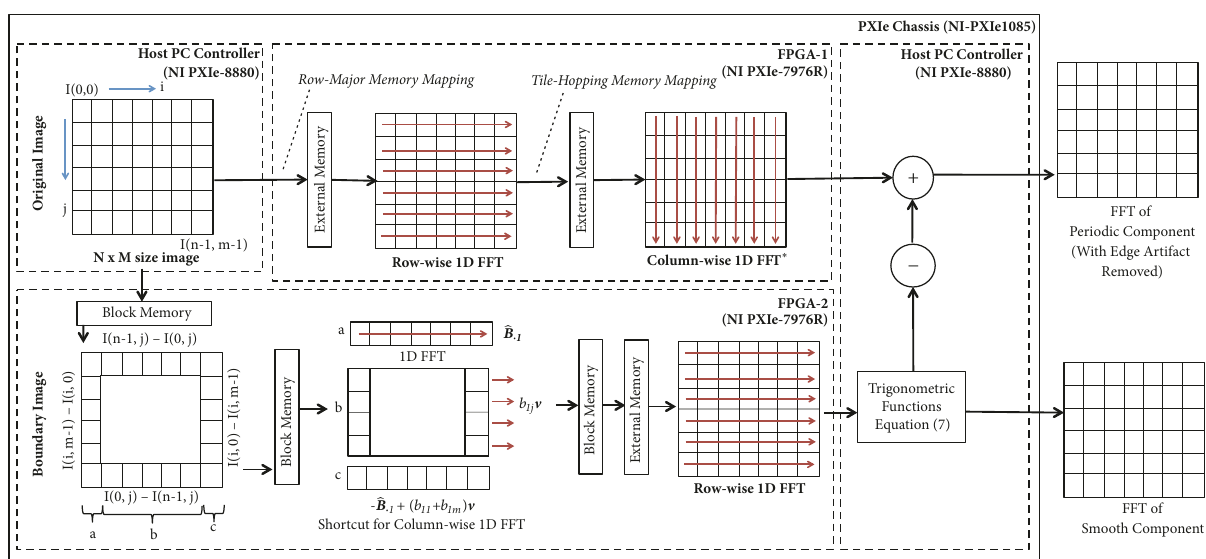
Figure8:FunctionalblockdiagramofPXIe-based2DFFTimplementationwithsimultaneousedgeartifactremovalusingoptimizedperiodic plus smooth decomposition. The OPSD algorithm is split among two NI-7976R (Kintex-7) FPGA boards with 2GB external memory and a host PC connected over a high-bandwidth bus. The image is streamed from the PC controller to FPGA 1 and FPGA 2. FPGA 1 calculates the row-by-row 1D FFT followed by column-by-column 1D FFT with intermediate tile-hopping memory mapping and sends the result back to the host PC. FPGA 2 receives the image, calculates the boundary image, and proceeds to calculate the 1D FFT column-by-column FFT using the shortcut presented in (16) followed by row-by-row 1D FFTs and the result is sent back to the host PC.